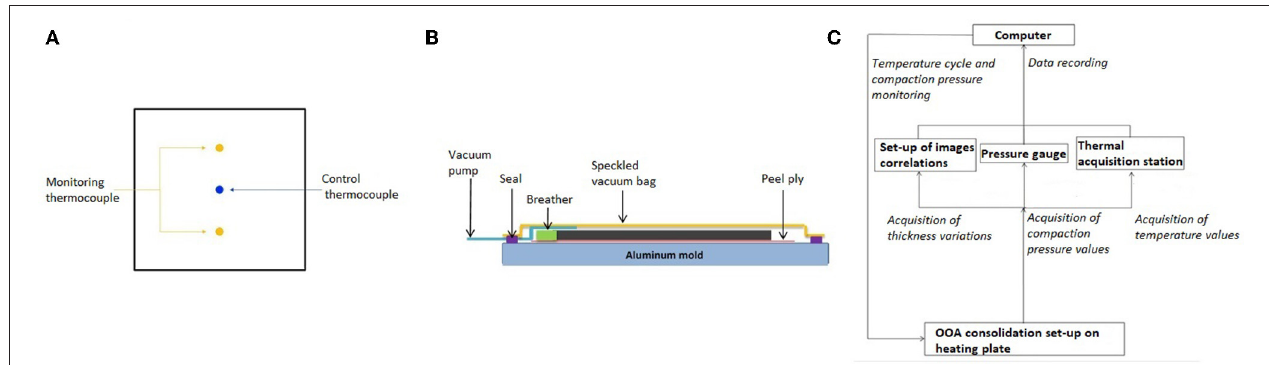
FIGURE 2 | In-situ monitoring system for out-of-autoclave consolidation of thermoplastic composites. (A) Scheme of thermocouples monitoring for oven manufacturing. (B) Schematic of prepreg lay-up. (C) Schematic diagram of in-situ monitoring system.